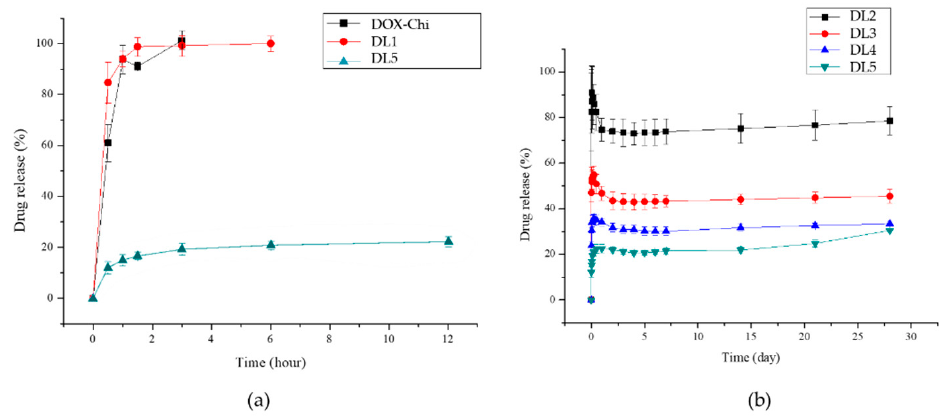
Figure 7. ( a ) DOX release profiles of DOX/chitosan, DL1, and DL5 samples over 24 h. ( b ) DOX release profiles of DL2, DL3, DL4 and DL5 over 1 month.